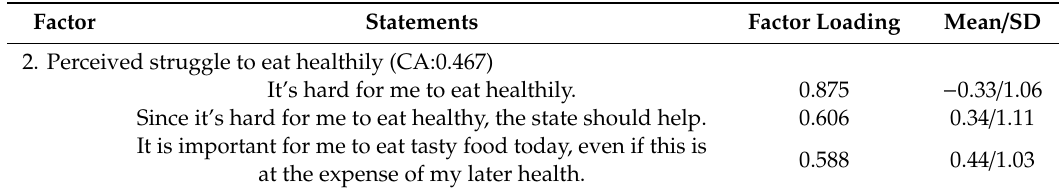
Table A3. The initial three statements of the factor ‘Perceived struggle to eat